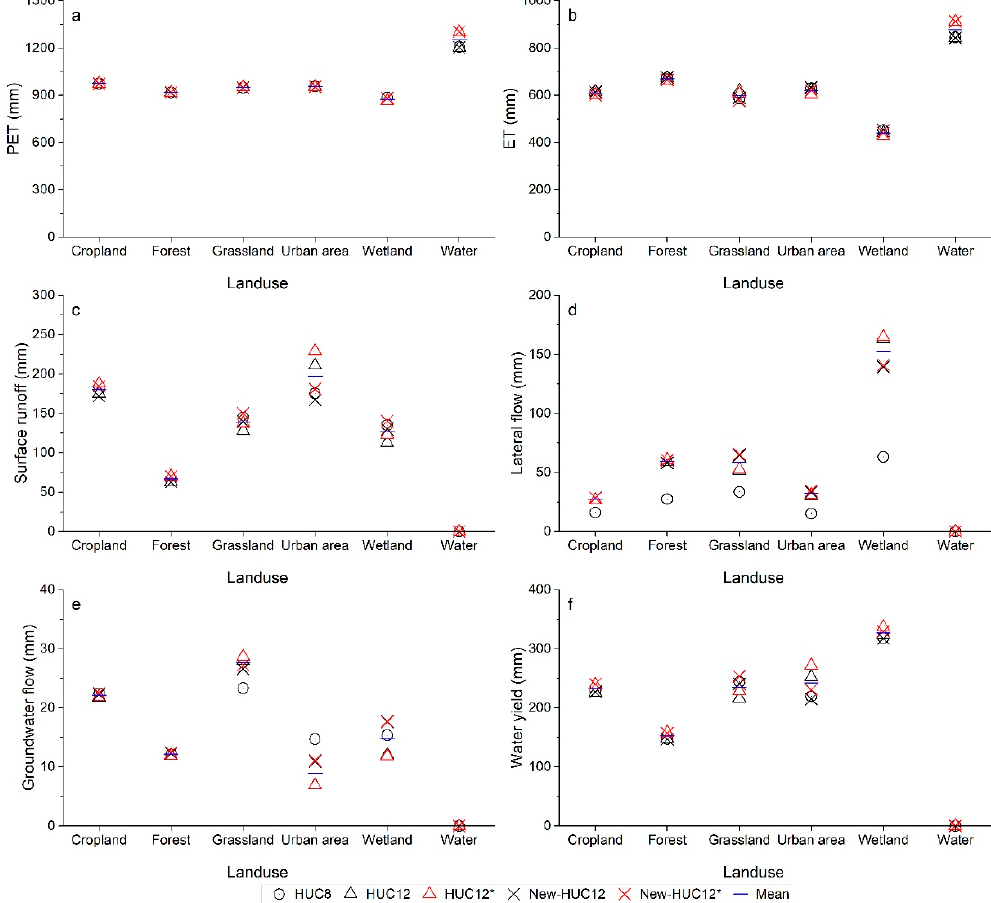
Figure 6. Average annual values of ( a ) potential evapotranspiration (PET), ( b ) evapotranspiration (ET), ( c ) surface runoff, ( d ) lateral flow, ( e ) groundwater flow and ( f ) water yield simulated with SWAT for different land uses during 1983 to 2005.